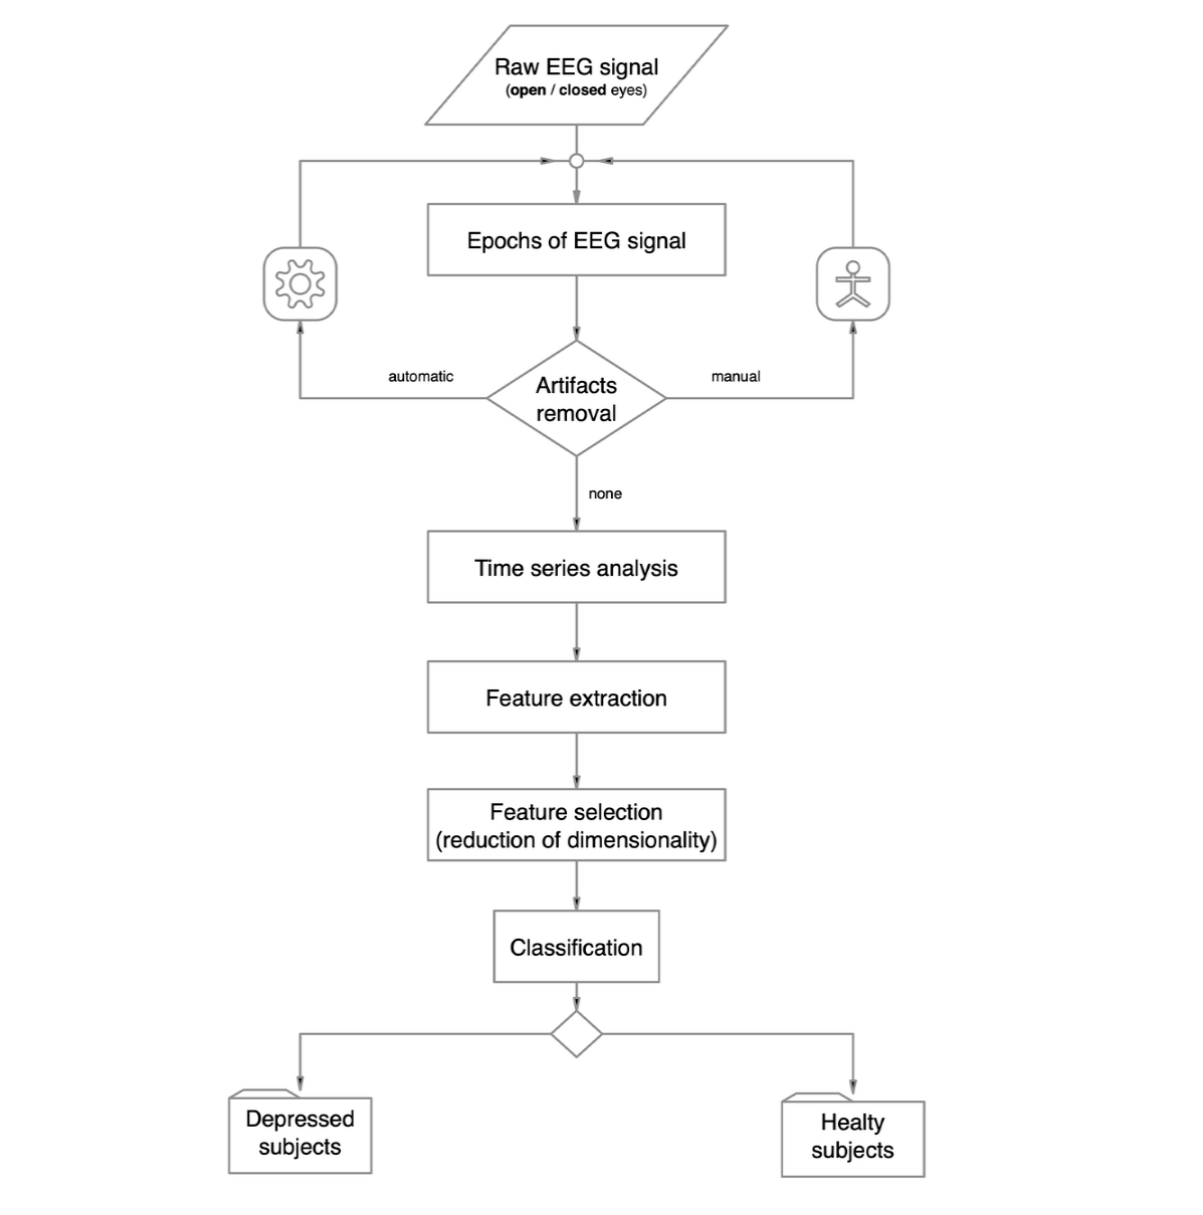
Figure 1. Flow diagram showing common stages in the analysis of resting-state EEG in all studies with varying approaches to classification. EEG: